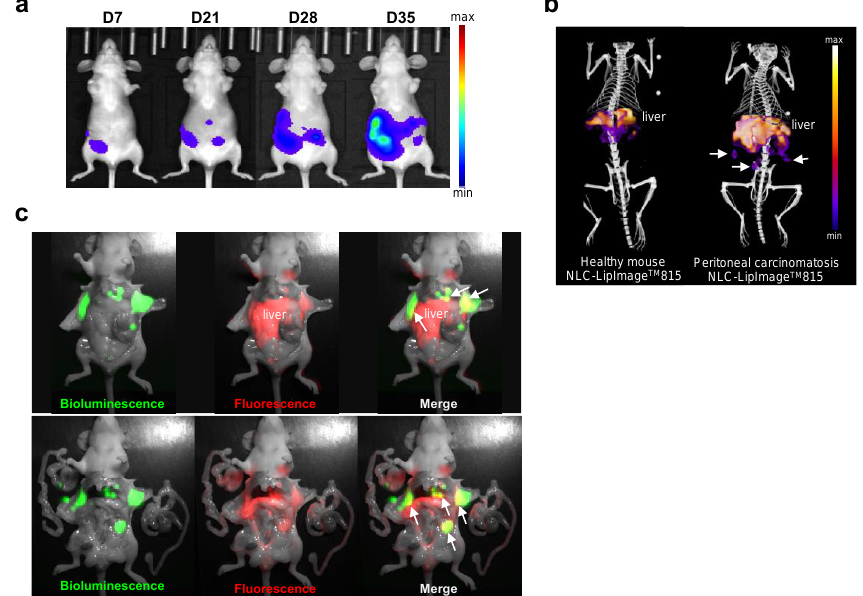
Figure 6. NLC-LipImage accumulated in ovarian tumor nodules after intravenous administration. ( a ) Orthotopic murine model of peritoneal carcinomatosis from ovarian cancer. Mice were inoculated with SKOV3-Luc cells into one ovary. Tumor growth and dissemination of tumor cells in the peritoneal cavity were followed by in vivo bioluminescence imaging over time. ( b ) Mice with peritoneal carcinomatosis or healthy mice were injected intravenously with NLC-LipImage TM -815 for 24 h, and imaged with fluorescence tomography/micro-computed tomography (microCT). Arrows show NLC-LipImage fluorescence in tumor nodules. ( c ) Mice with established peritoneal carcinomatosis were injected intravenously with NLC-LipImage, and were submitted to intraoperative fluorescence in combination with bioluminescence after 24 h. Representative images of one operated mouse (upper panel), and with extended organs exposition after liver removal (lower panel) are shown. Bioluminescence showed SKOV3 cells in the peritoneal cavity (in green) and 2D-fluorescence imaging showed NLC-LipImage location (in red). Arrows show NLC-LipImage and SKOV3 tumor nodules signals colocation (in yellow).